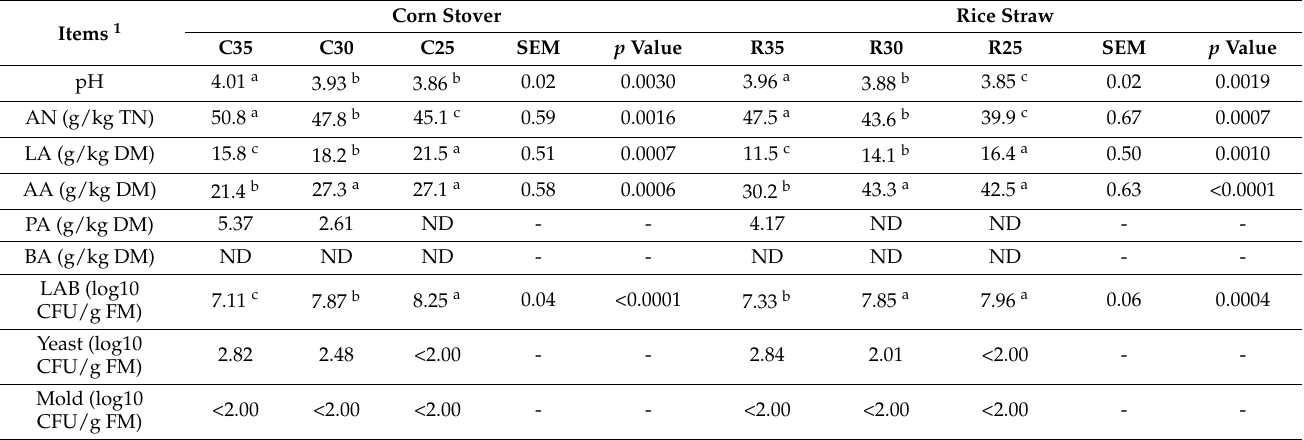
Table 4. Organic acids concentration, pH, and microbial population of soybean curd residue mixed with corn stover or rice